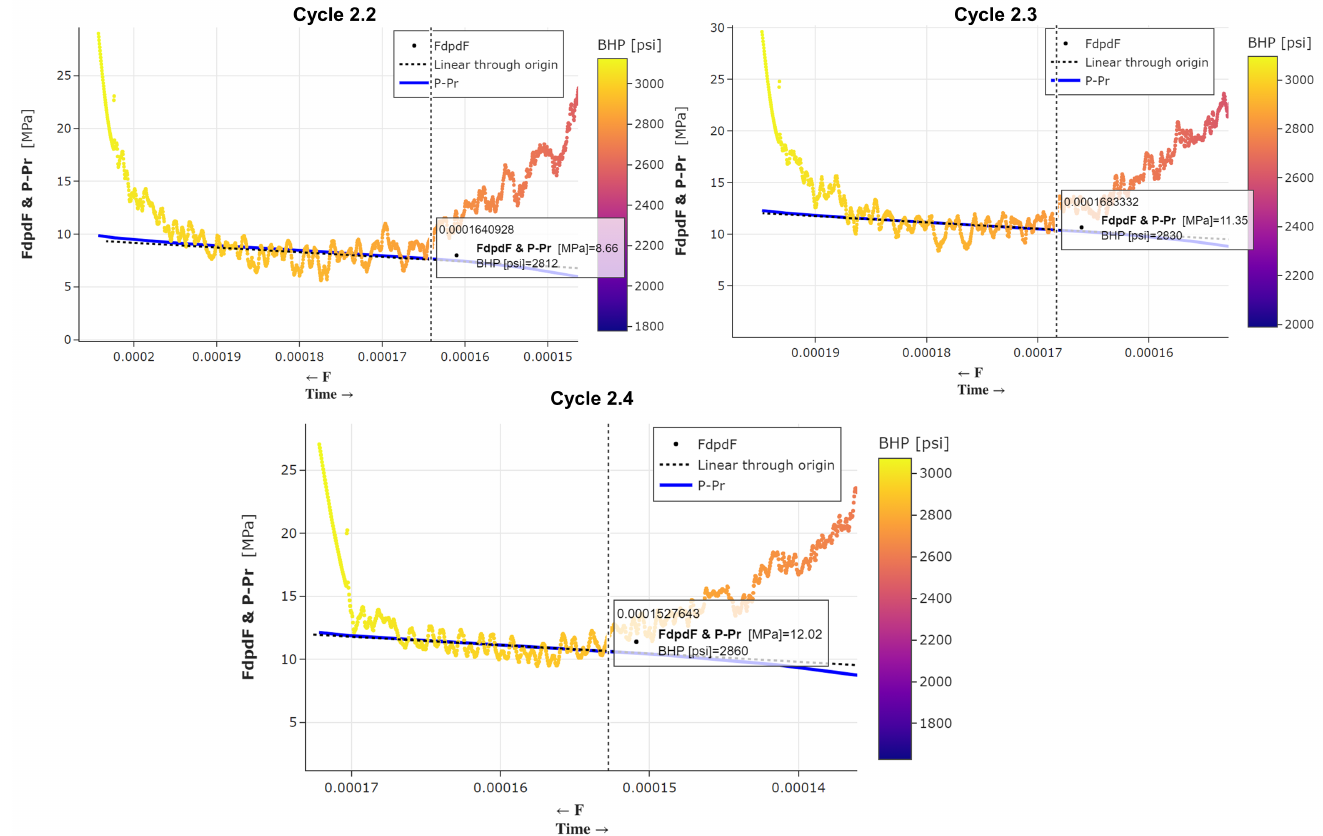
Figure 27. F-function of the shut-in test 8 cycles 2.2,2.3, and